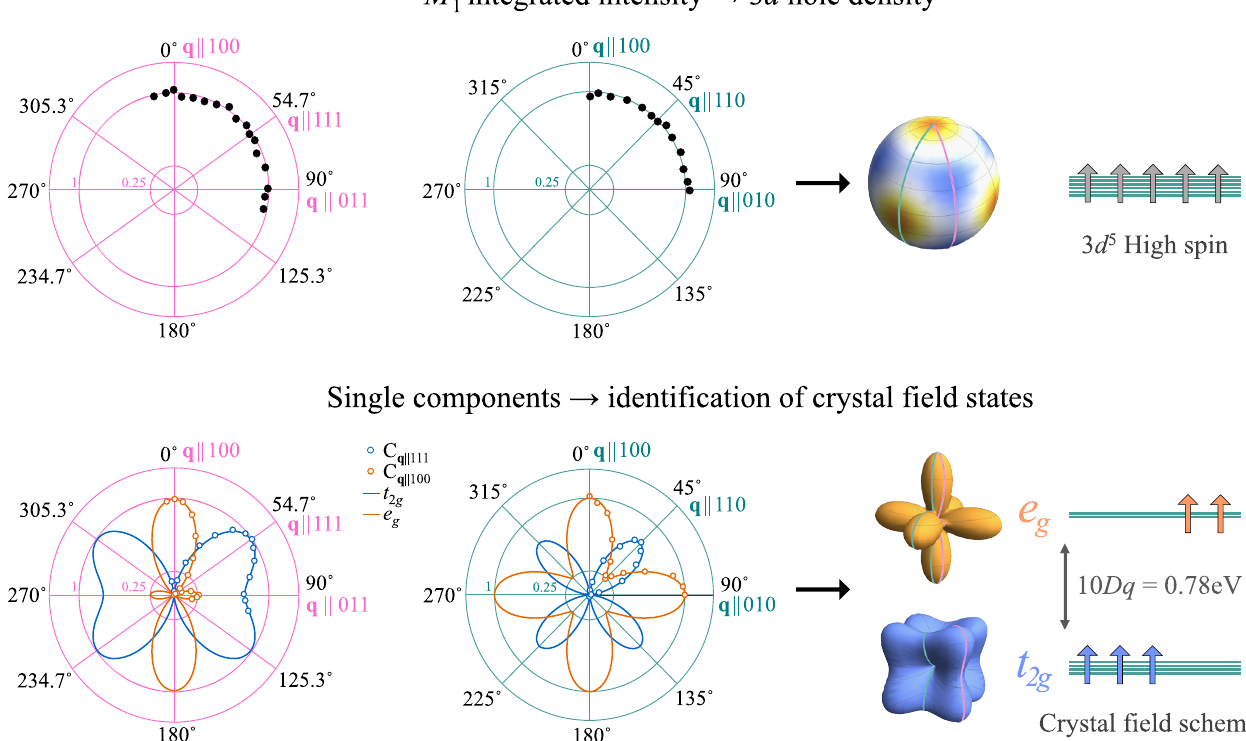
(magenta) and in Fig. 2(b) for q k ½ 100 (cid:2) → ½ 110 (cid:2) → ½ 010 (cid:2)